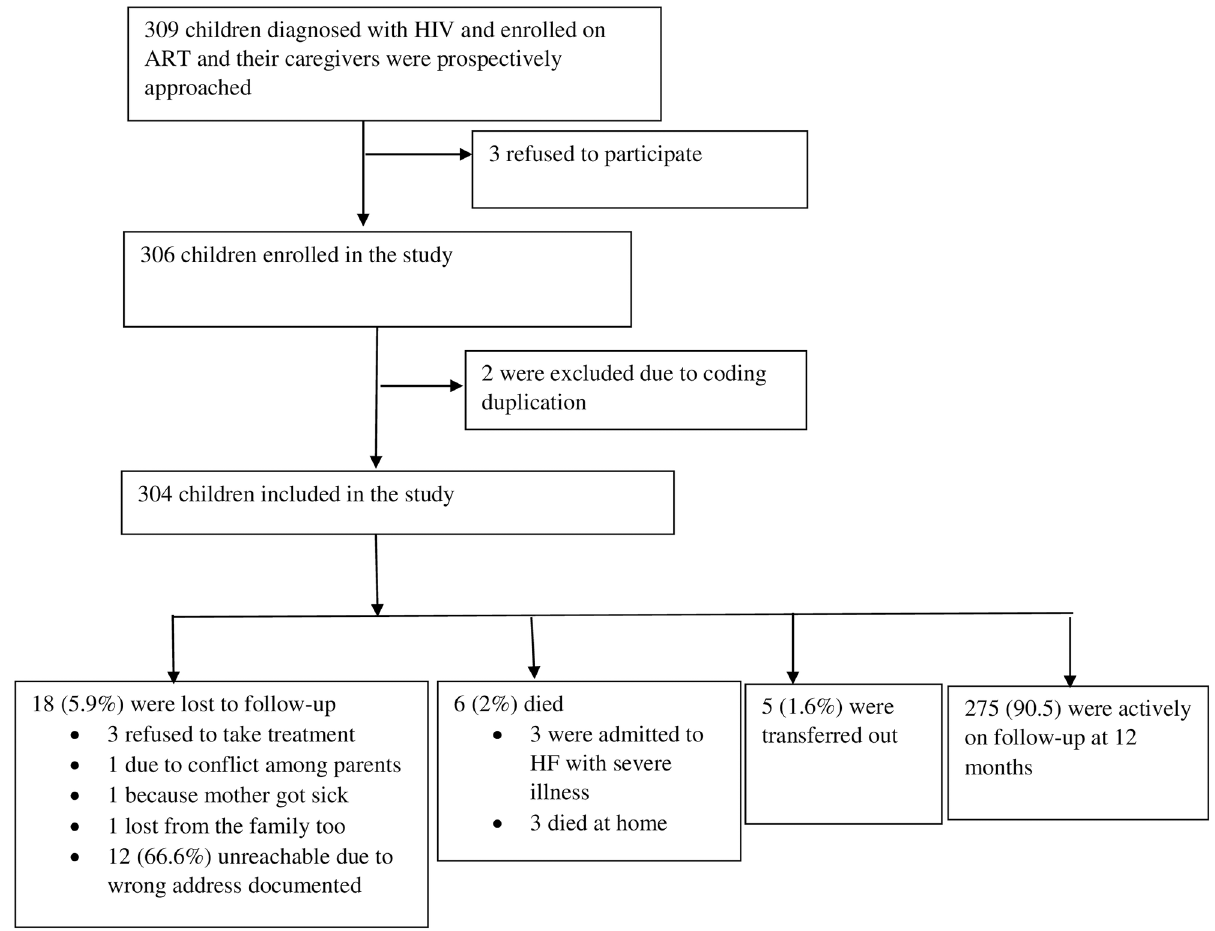
Fig 1. Flow chart showing the cohort